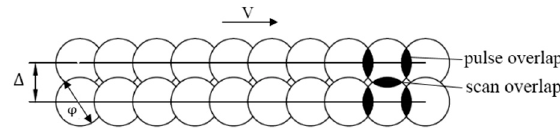
Figure 2. The scheme of the laser surface texturing processing.